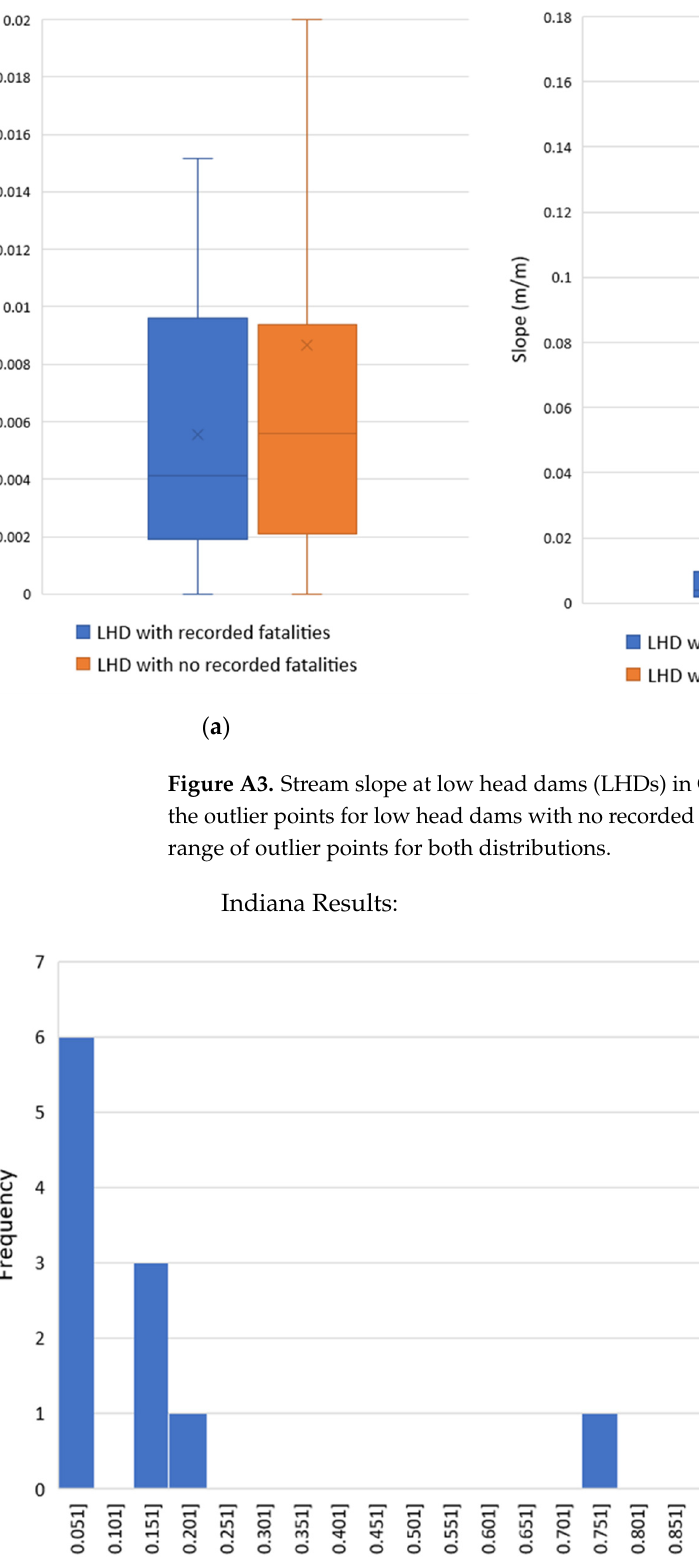
Figure A2. Stream slope at low head dams in Colorado with no fatalities recorded.